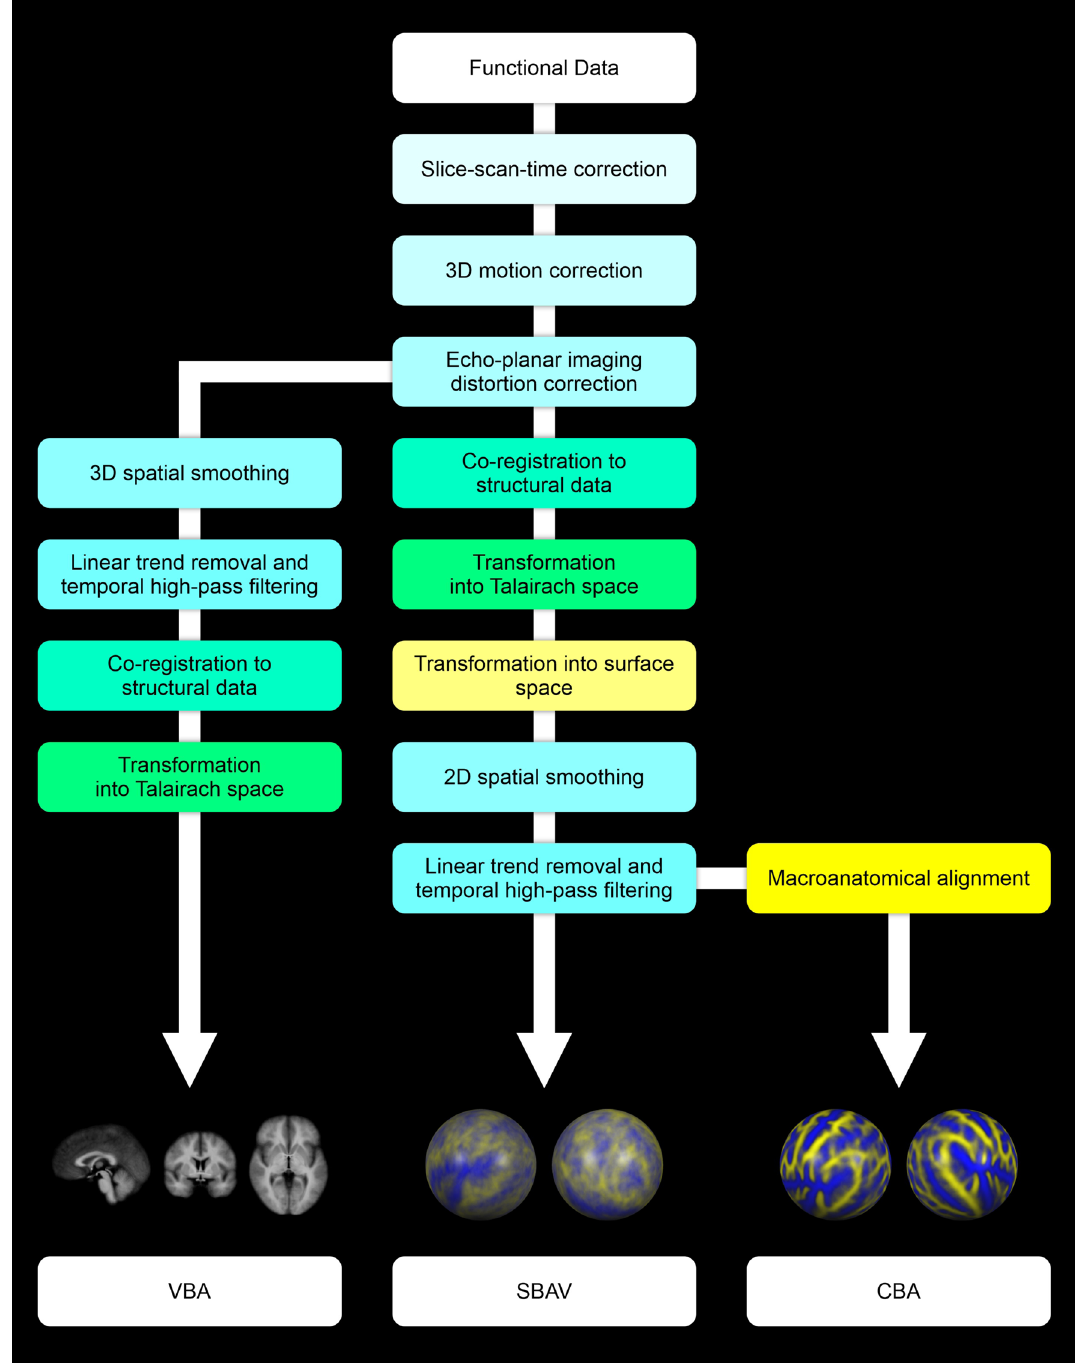
Figure 7. Sequences of functional data pre-processing, coregistration of structural and functional data and spatial transformation operations used to generate the three functional data sets used in our study: VBA, SBAV and CBA. For VBA we conducted all data pre-processing operations in volume space, including slice-scan-time correction, 3D motion correction, echo-planar imaging distortion correction, 3D spatial smoothing and linear trend removal with temporal high-pass filtering. Finally, functional data were co-registered to the structural data and transformed into Talairach space. For SBAV and CBA, we conducted all data pre-processing operations up to echo-planar imaging distortion correction in volume space. Here, co-registration of functional data to the structural data and transformation into Talairach space was followed by transformation into surface space. We then conducted 2D spatial smoothing and linear trend removal with temporal high-pass filtering in surface space. For CBA only, we subsequently applied macroanatomical